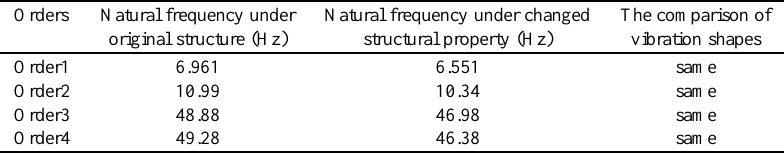
Table 5 The structural different properties with single side constraint